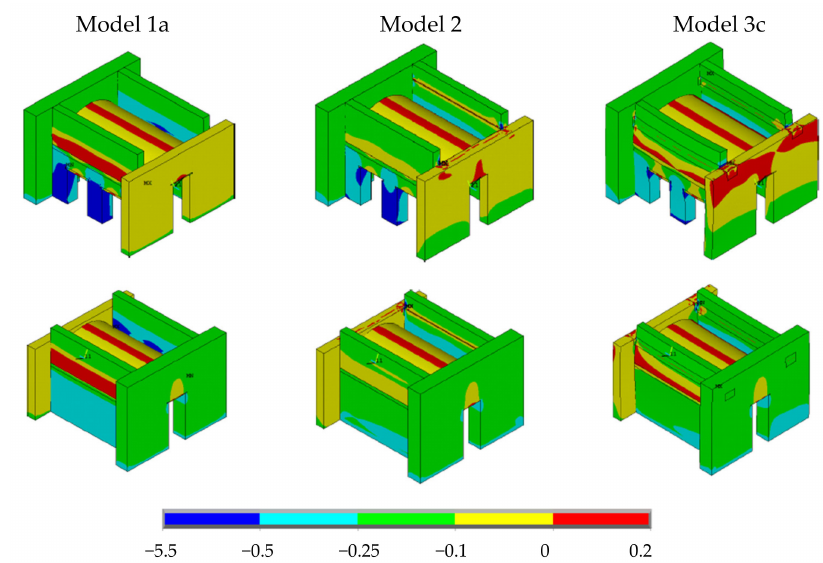
Figure 18. Vertical stresses in [N/mm 2 ] in the walls (Set 1.1 of Table